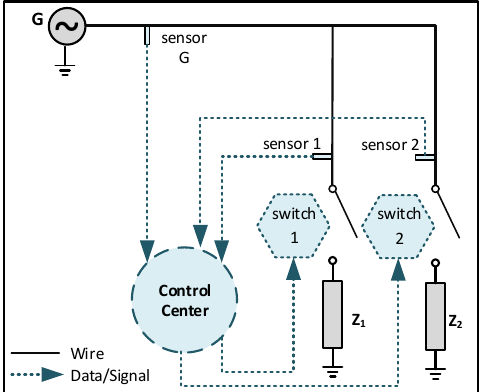
Figure 4. A single generator smart grid system